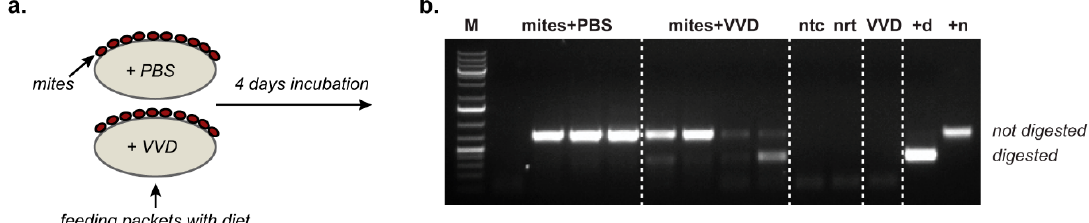
artificial diet supplemented with RG VVD DWV in PBS or PBS only (control); ( b ) 1% agarose gel with HpaI -digested PCR products amplified using a DWV negative strand-specific RT-PCR assay. Specific (-)RNA PCR products from Varroa mites fed with artificial diet supplemented with VVD virus stock (“mites + VVD”) or PBS (“mites + PBS”); four groups of 10 mites were used for each feeding condition - each lane corresponds to a pooled sample of mites from one group (fed on the same diet packet), “ntc” and “nrt”—no template and no RT controls, respectively, “VVD”—negative strand-specific